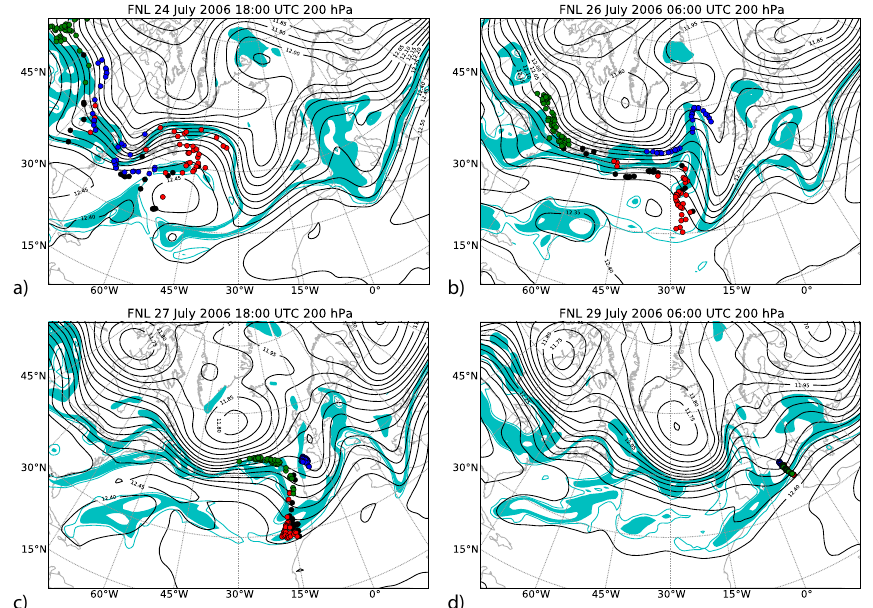
Fig. 8. Backward-trajectories of four groups of selected sets of air parcels. Black contour lines show geopotential height at 200hPa. The cyan contour line indicates a potential vorticity of 1.5PVU, while the cyan surface indicates a potential vorticity of 2 to 4PVU at 200hPa. The coloured circles correspond to the horizontal position of the similarly coloured air parcels highlighted in Fig. 6 at the time given in the respective title.